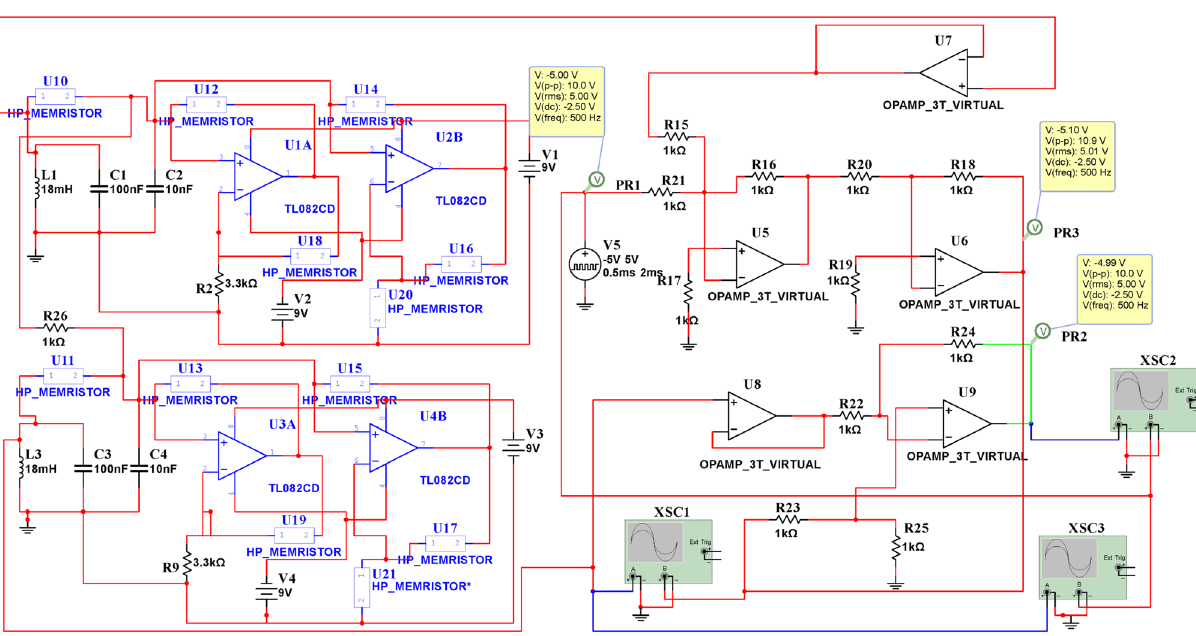
Fig. 19 Design of memristor-based Chua’s chaotic circuit—non-identical transmitter and receiver